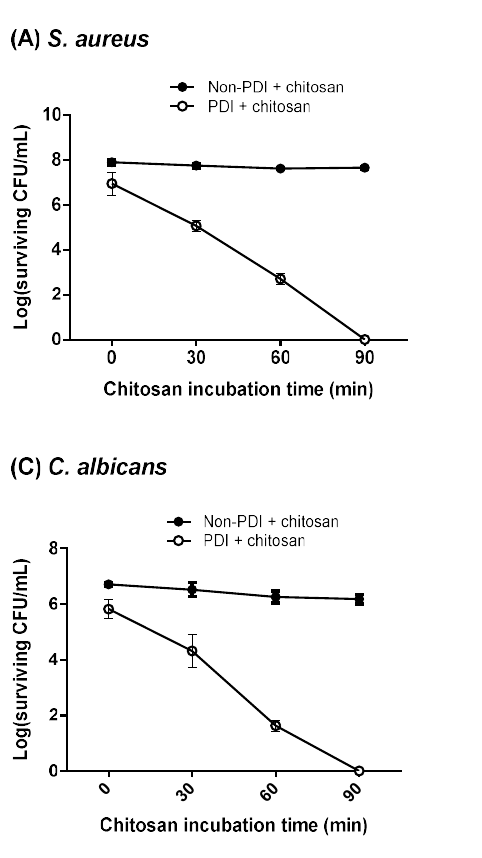
Figure 3. Increase in the chitosan incubation time dramatically enhanced the killing effect. The concentration of photosensitizer TBO used in PDI was 10 μM in ( A ) S. aureus and ( B ) P. aeruginosa . ( C ) For C. albicans , 150 μM of TBO was used for PDI. After light irradiation (50 J cm −2 ), chitosan was added and further incubated for different time periods. The concentrations of chitosan used for S. aureus and P. aeruginosa were 0.025% and 0.25%, respectively. For C. albicans , 0.25% chitosan was used for the post incubation after PDI. After each incubation period, an aliquot of microbial cells was removed for plate count. Each value is the mean obtained from three independent experiments ± SD.